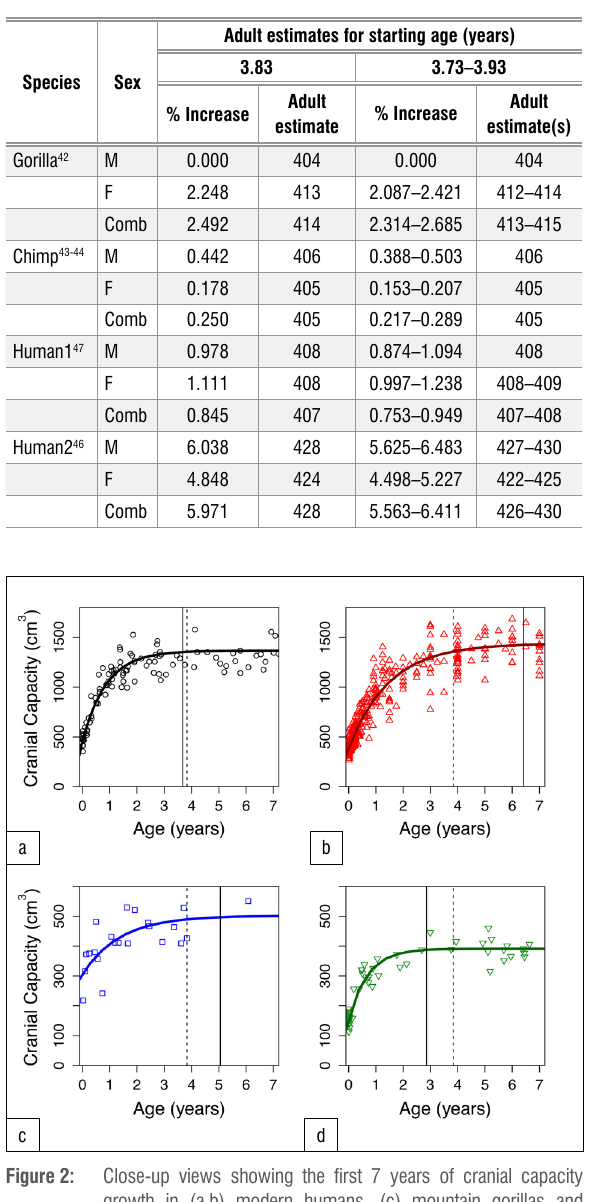
Figure 2: Close-up views showing the first 7 years of cranial capacity growth in (a,b) modern humans, (c) mountain gorillas and (d) chimpanzees. In each panel, the dashed vertical line indicates the ‘starting age’ for Taung and the solid vertical line indicates the point of 99% growth completion.